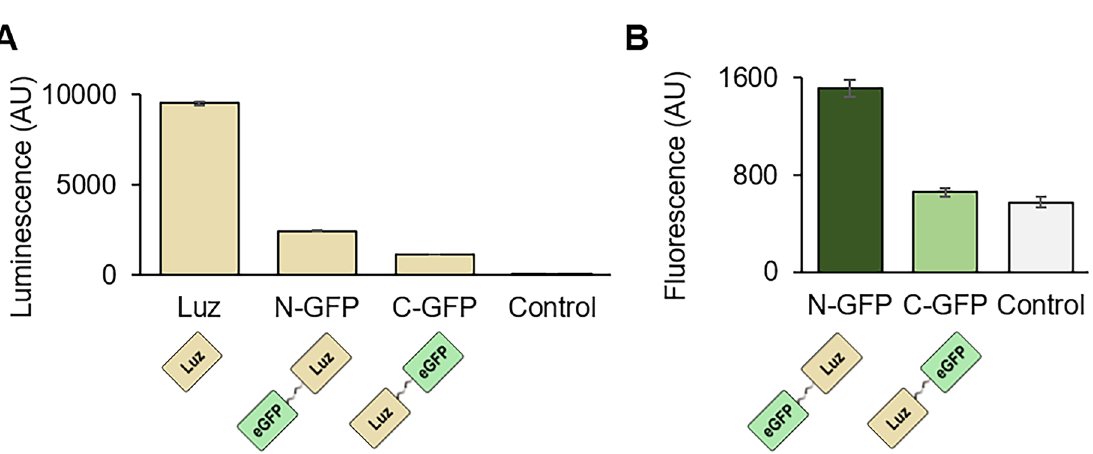
Figure 5. Luz’s capacity as reporter gene fusions. ( A ) Luminescence measurement of the H3H-Luz system with the eGFP fused Luz constructs. H3H and Luz were expressed in TXTL. After the expression, hispidin and NADPH were added, followed by luminescence measurement. ( B ) Fluorescence measurement of the eGFP fused Luz. Luz proteins were expressed in TXTL and the fluorescence was measured. Luz, Luz luciferase without a fusion protein; N-GFP, N-terminal eGFP fusion with Luz; C-GFP, C-terminal eGFP fusion with Luz; Control, reaction without enzyme expression. The graphs show means with error bars that signify SEM (n =